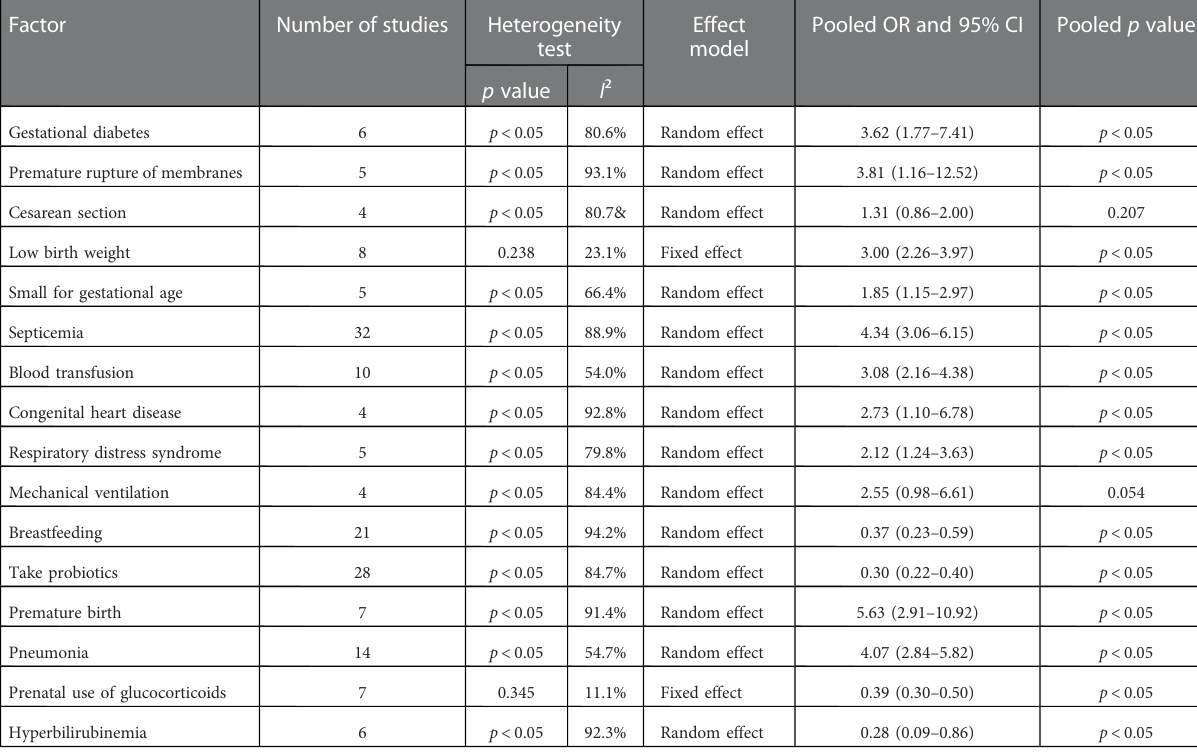
TABLE 2 Heterogeneity test and meta-analysis results of risk